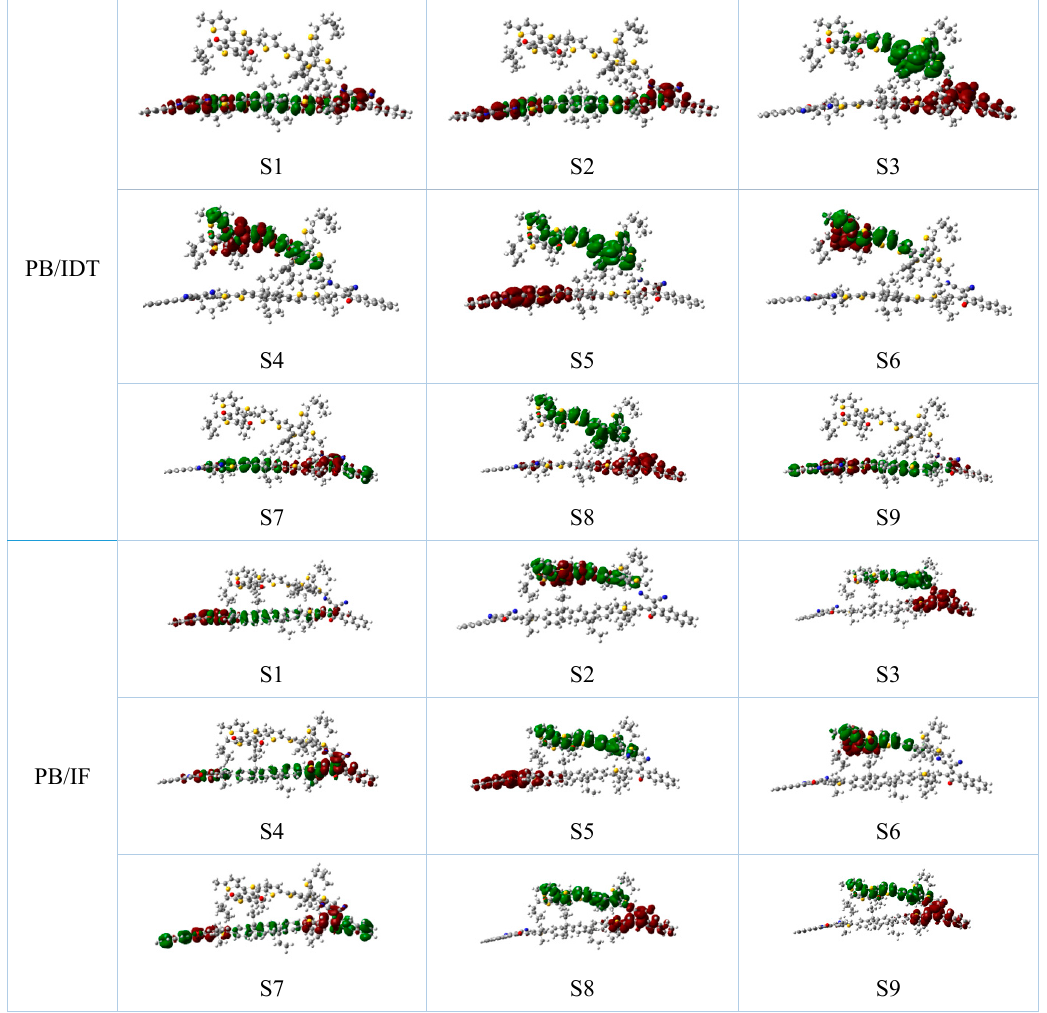
Figure 4. The representative charge difference density plots of two interfaces (PB/IF and PB/IDT) (red represents electrons, green represents holes).